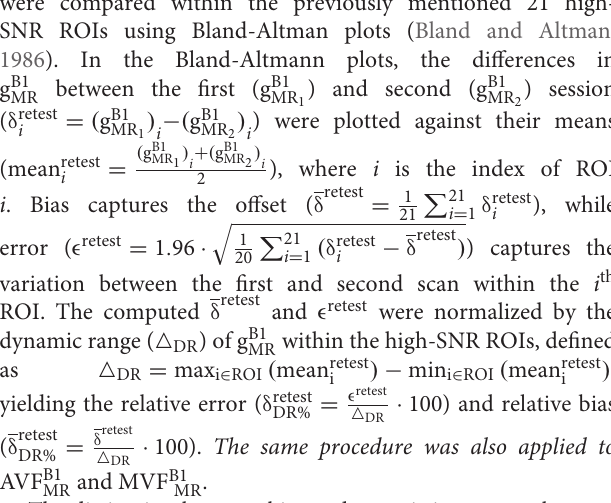
FIGURE 5 | Voxel-wise maps of group-averaged g B1 MR , AVF B1 MR , and MVF B1 MR , restricted to the group WM mask (cf. section “Definition of White Matter Masks”). Depicted are a single sagittal (x = 100), coronal (y = 91), and axial (z = 85)